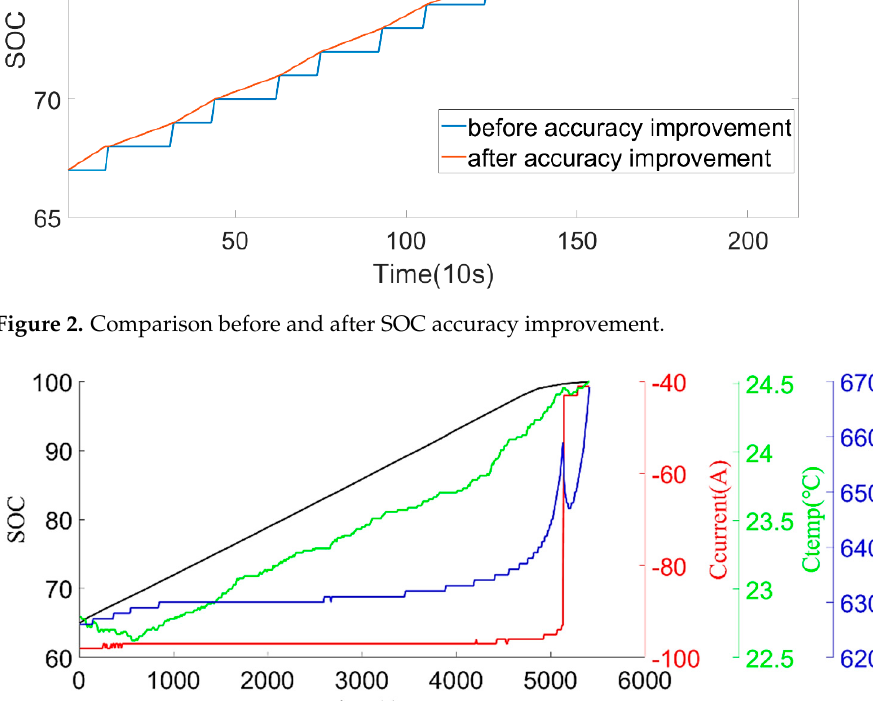
Figure 3. Example of charging process: pack SOC, pack charging current (Ccurrent), pack charging temp (Ctemp), and pack charging voltage (Cvoltage).